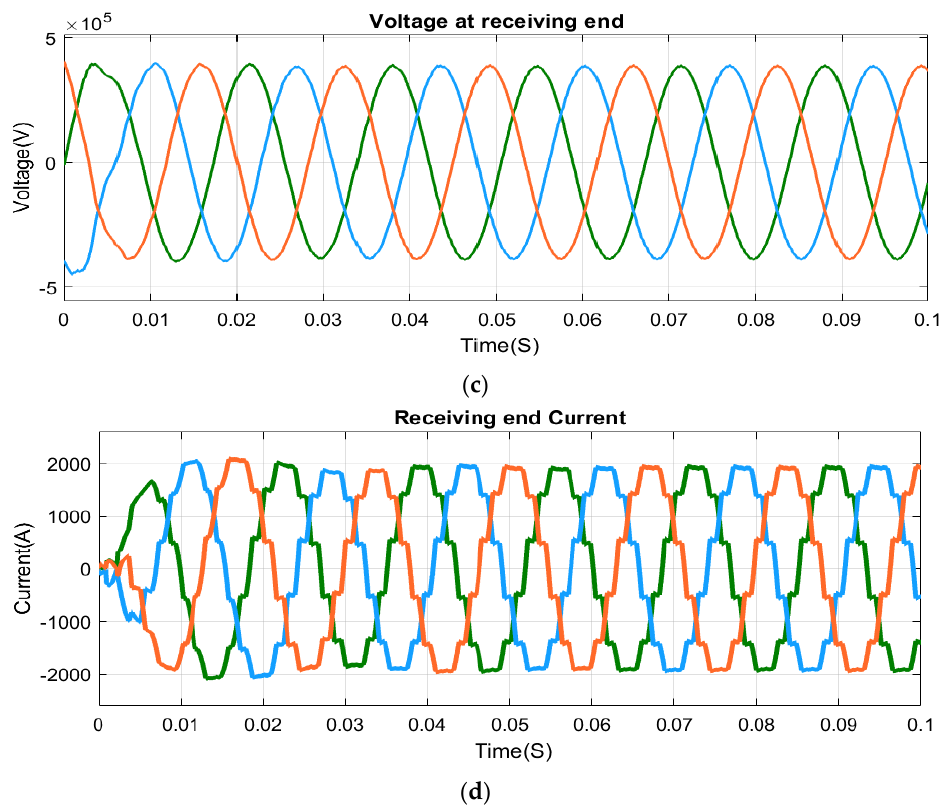
Figure 7. ( a ) Voltage waveform at sending end. ( b ) Current waveform at sending end. ( c ) Voltage waveform at receiving end with harmonic filters. ( d ) Current waveform at receiving end with harmonic filters.